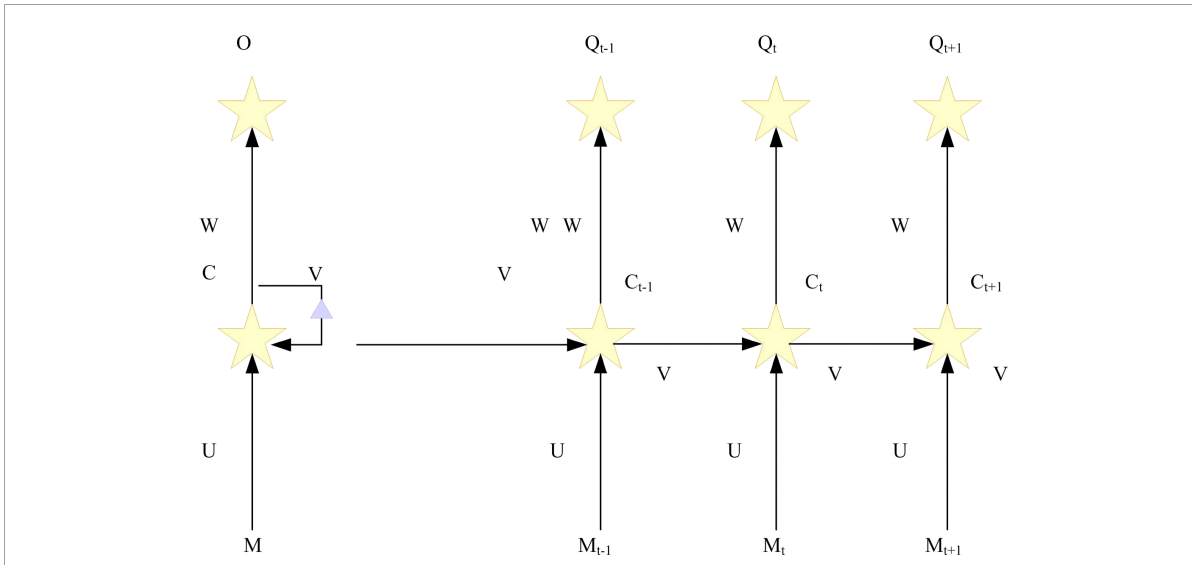
FIGURE3 Recurrent neural network (RNN) model.